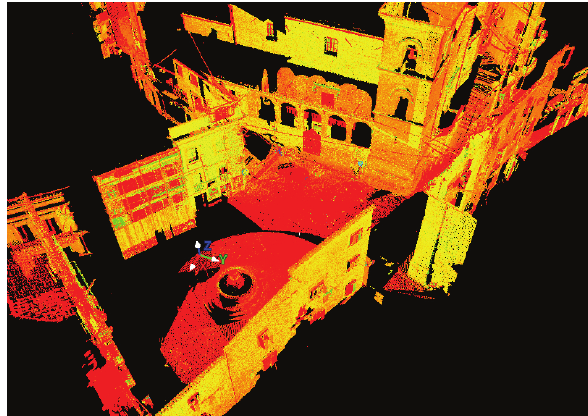
Figure 5. View of the assembled Francesco Neglia square’s point cloud model